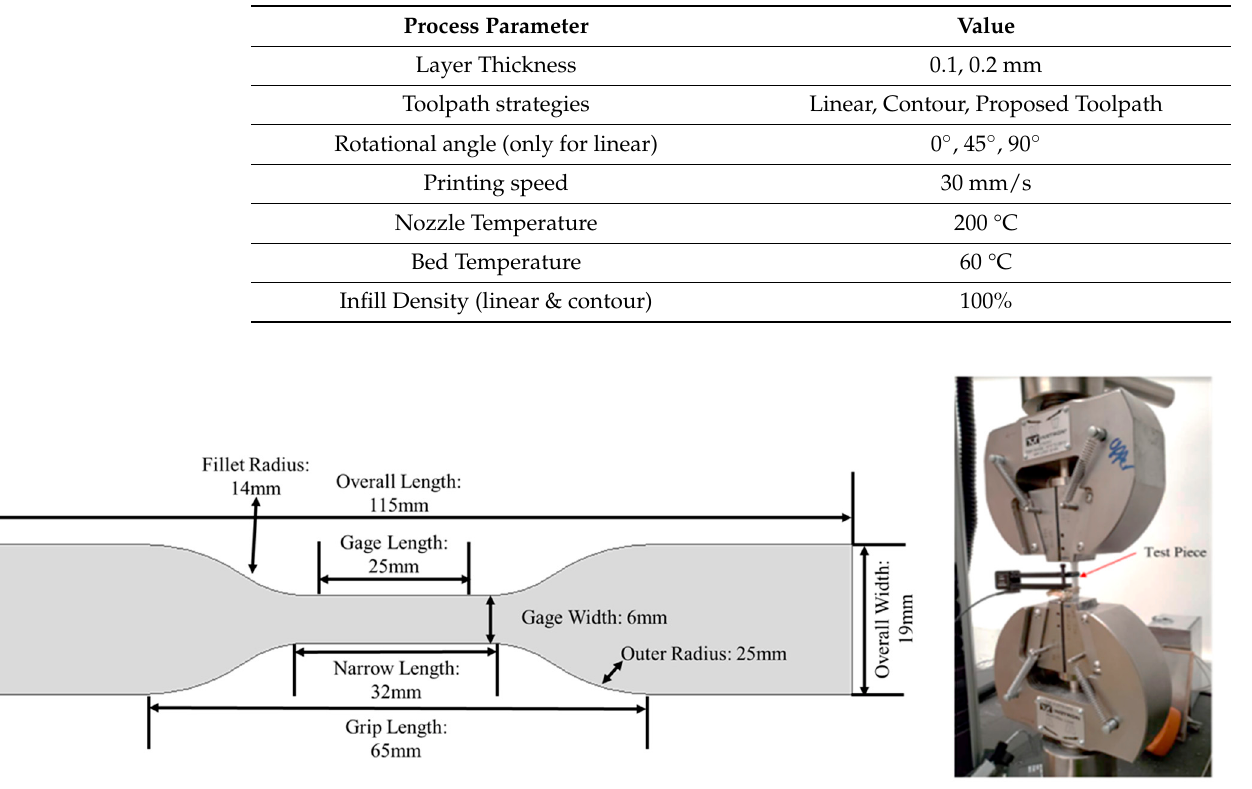
Figure 6. Test specimen (ASTM D638 IV) and test setup for tensile